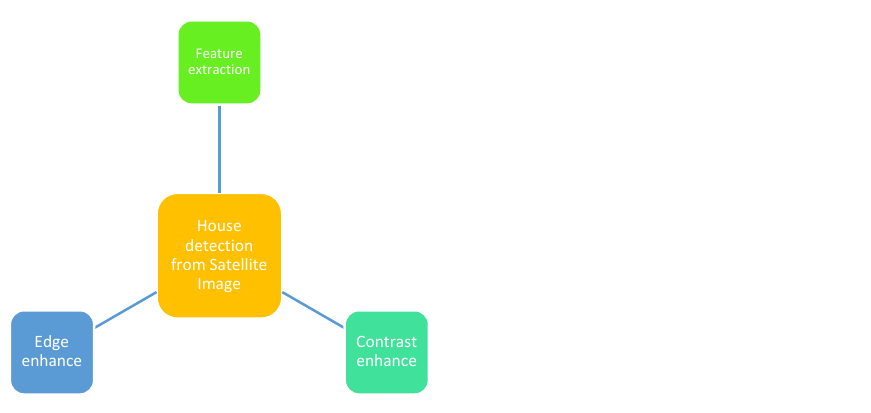
Figure 5. Example of mind map for house detection from remote sensing satellite images.